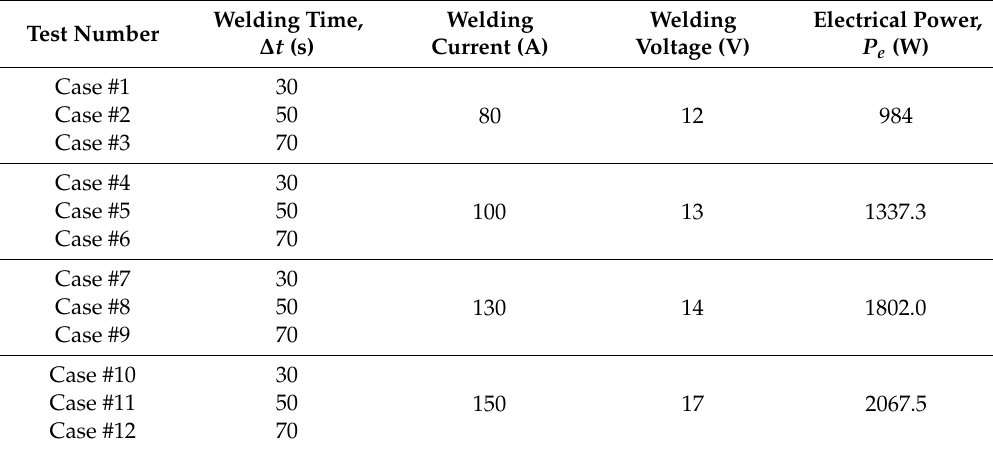
Table 2. Experimental conditions to study the effects of thermal characteristics of welding spatter on the welding time and electrical power.